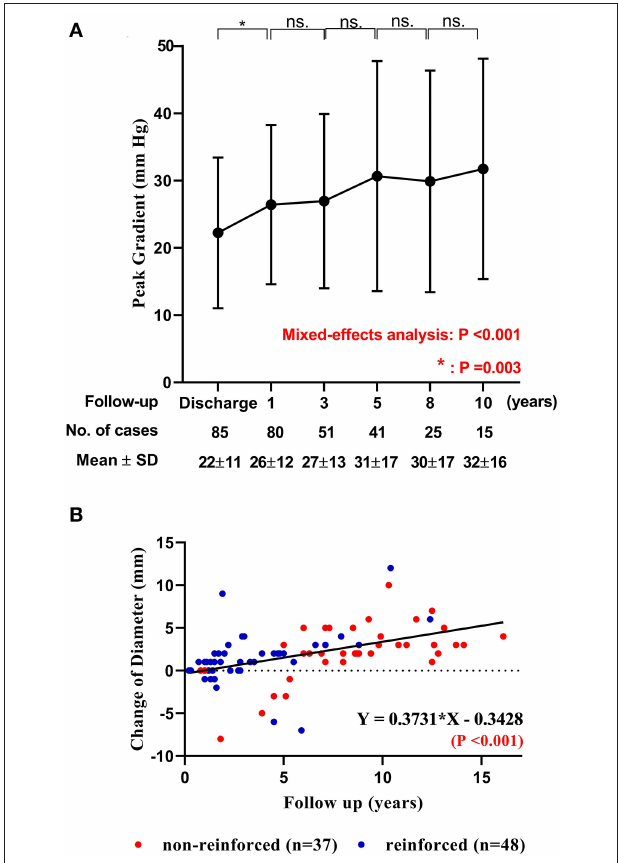
FIGURE 3 | The change of peak gradient and diameter of DP-BJVC. (A) Peak pressure gradient across the conduit measured by echocardiography before discharge and at 1, 3, 5, 8 and 10 years after implantation are presented with mean and standard deviation (SD). The gradient significantly increased with time ( P < 0.001). The comparisons of adjacent time show that the increase mainly occurred in the first postoperative year ( P = 0.003), which become slightly thereafter ( P > 0.05). ns, no significance. (B) The change of DP-BJVC diameter measured by echocardiography at the annular level from implantation to the last follow-up significantly and positively linear correction with the follow-up years. Each dot represents one patient. The diameter change of reinforced conduits (red dots) have similar regression coefficient with the non-reinforced conduits (blue dots. P = 0.806). Four conduits (arrows) had a diameter decrease over 5mm early after implantation, which were all caused by stenosis and had been replaced.